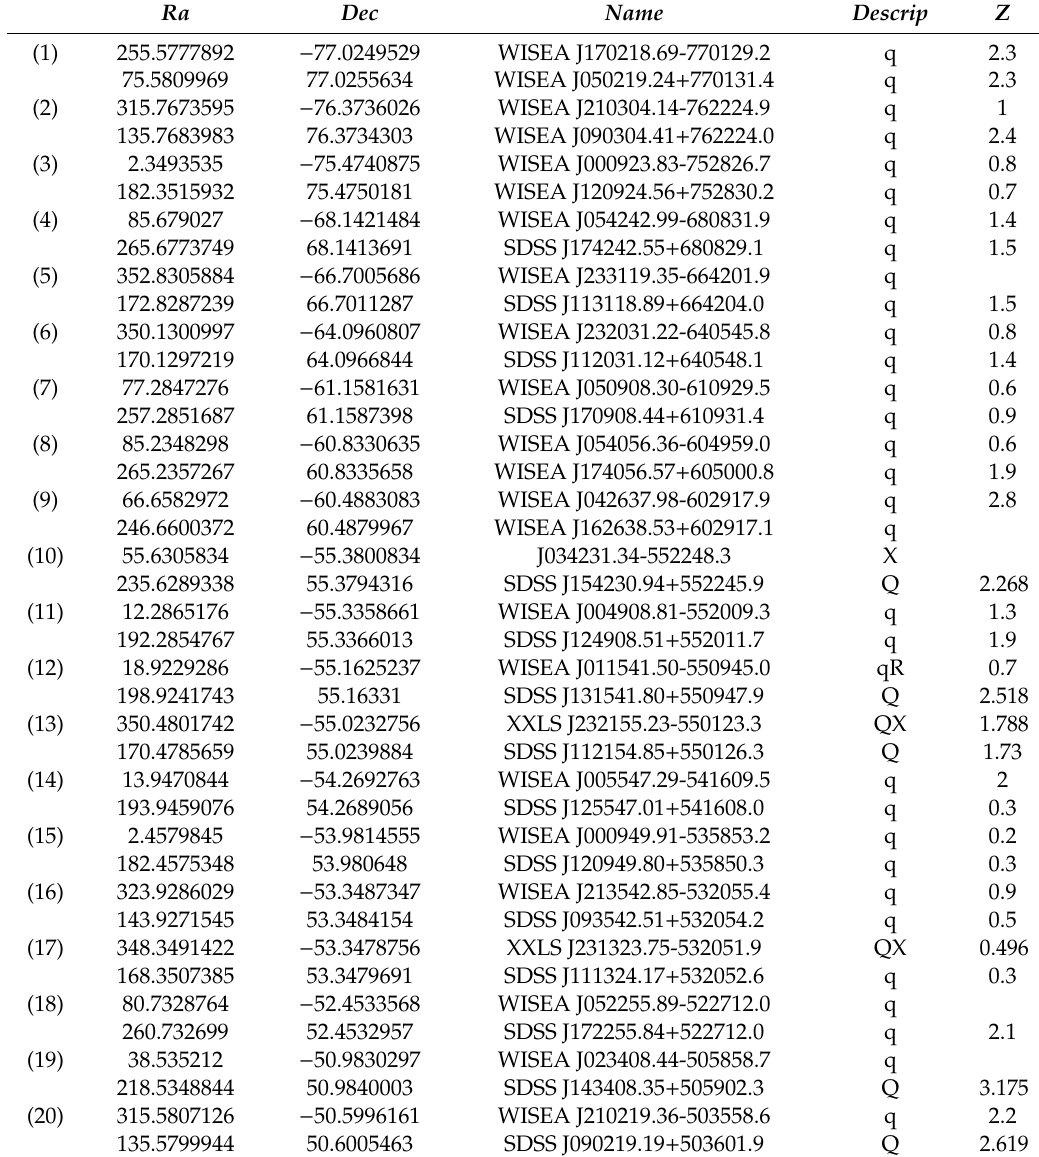
Table A12. Pairs of opposite quasars from the Milliquas 6.3 catalog for the lens e ff ect. Accuracy is of 0.001 ◦ for ra and dec . Descrip column is the classification of object, see [47]. Redshift z is given when available, although is not essential